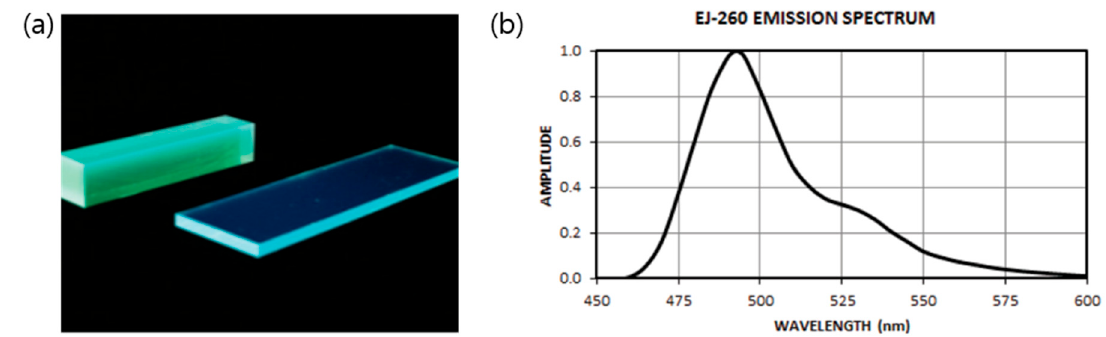
Figure 3. EJ-260: ( a ) EJ-260 scintillator, ( b ) EJ-260 scintillator emission spectrum with wavelength [66].